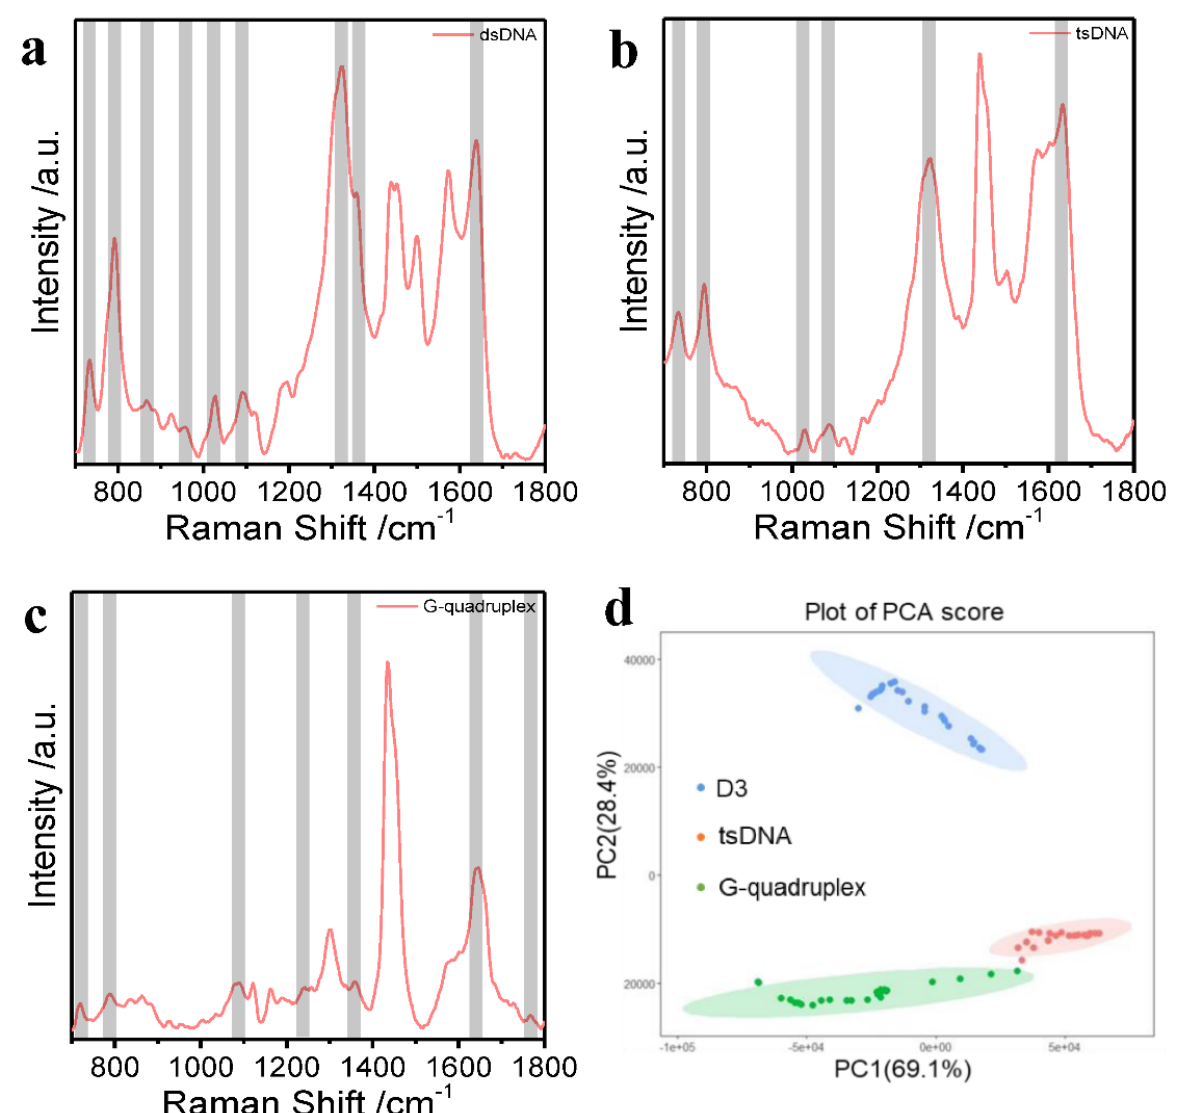
Figure 5. ( a ) SERS spectrum of dsDNA D3; ( b ) SERS spectrum of tsDNA; ( c ) SERS spectrum of G-quadruplex; ( d ) PCA analysis of the SERS spectral characteristics of dsDNA, tsDNA, and G-quadruplex in an aqueous solution.